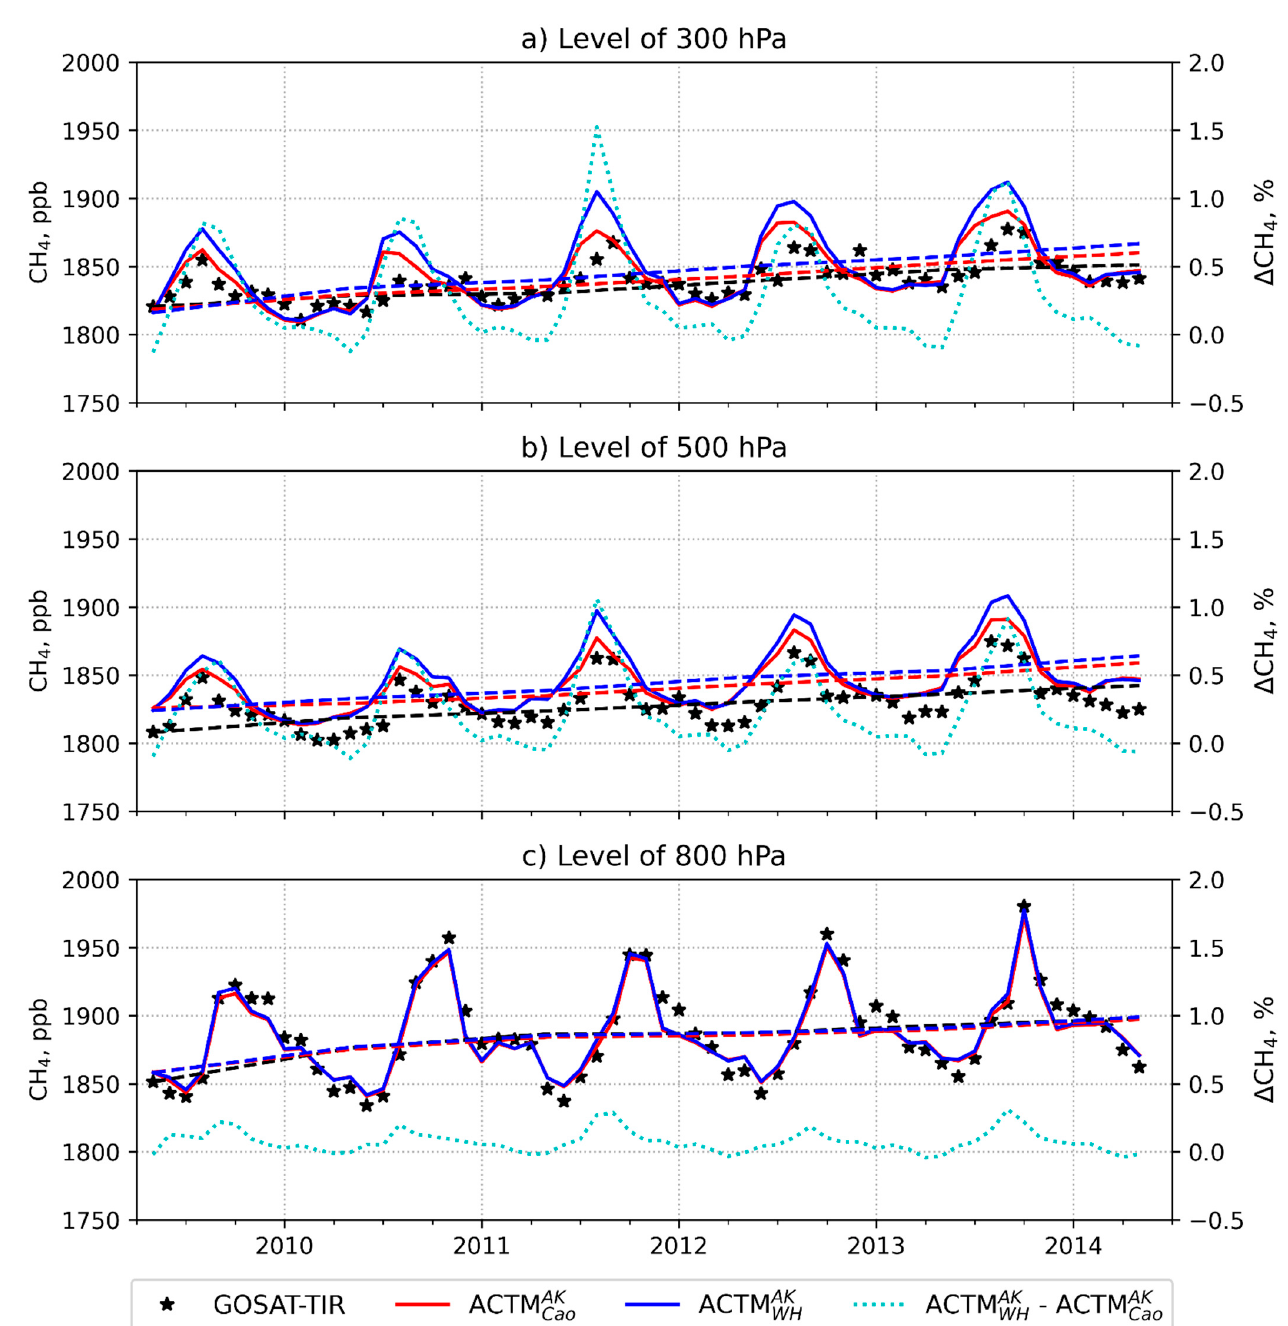
Figure 12. Time series of CH 4 averaged over the area of South Asia for levels of ( a ) 300, ( b ) 500 and ( c ) 800 hPa. Symbols state the GOSAT-TIR observations, red and blue lines are for ACTM AK , and ACTM AK , respectively. Solid and dashed lines are for monthly and yearly averaged concentrations (left y -axis), and dotted line shows the difference between the model simulations (right y -axis), respectively. The same results, but without implementation of the AK functions is shown in Figure S9.